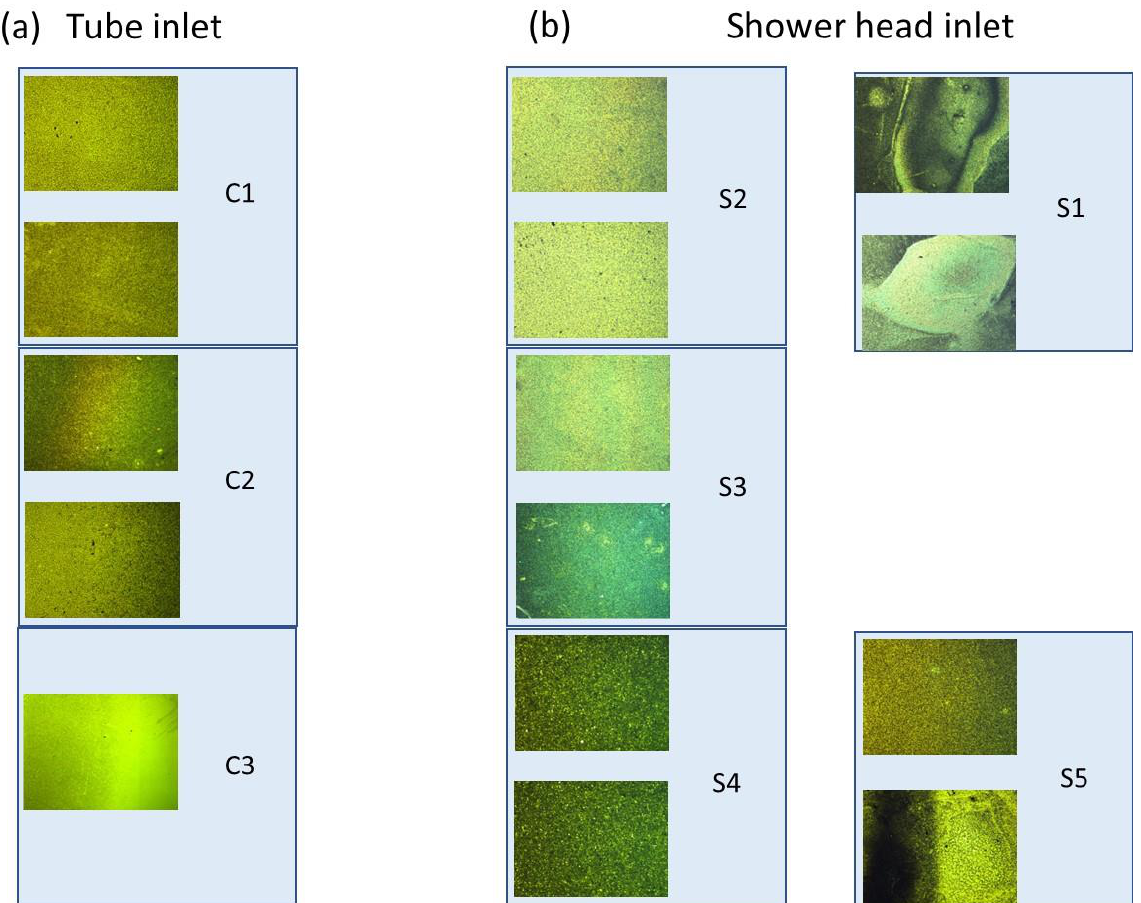
Figure 5. Optical reflection images for samples grown using a tube ( a ) and a shower head ( b ) as the inlet. The images were taken with a magnification of 50×.